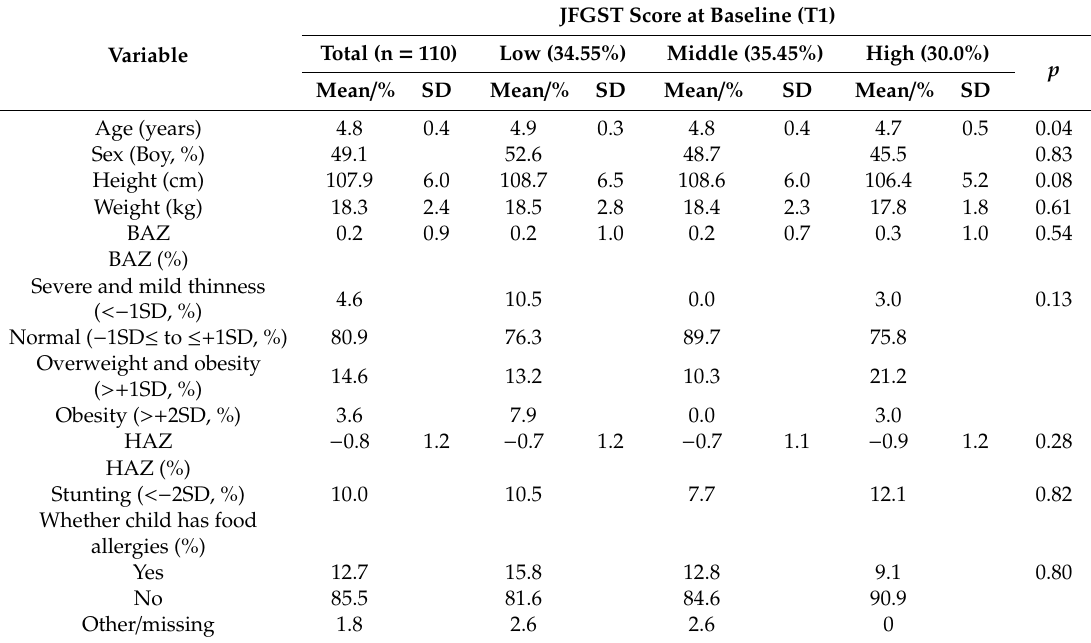
Table 2. Characteristics of the study population at baseline (T1) ( n =